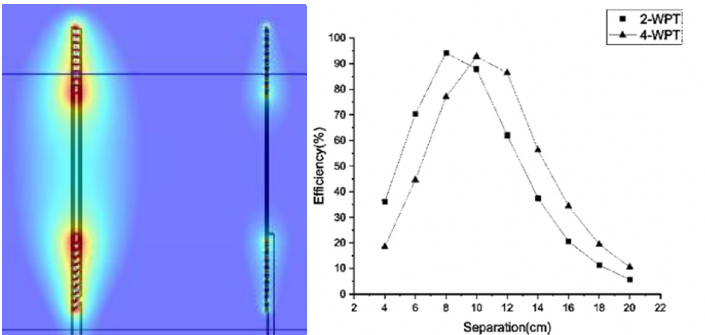
Figure 5. Simulated coils in the magnetic field ( left ) and the coil separation study at a resonance of 5 MHz ( right